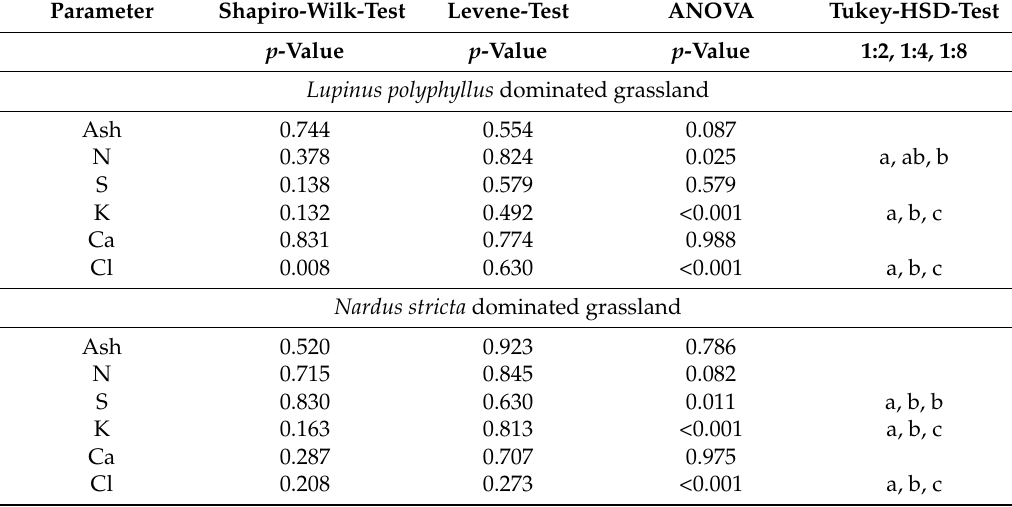
Table 2. Experiment 2: Statistical results for ash, N, S, K, Ca and Cl concentrations in press cakes of grassland dominated by Lupinus polyphyllus or Nardus stricta created by leaching with water to biomass ratios of 1:2, 1:4 or 1:8, respectively.